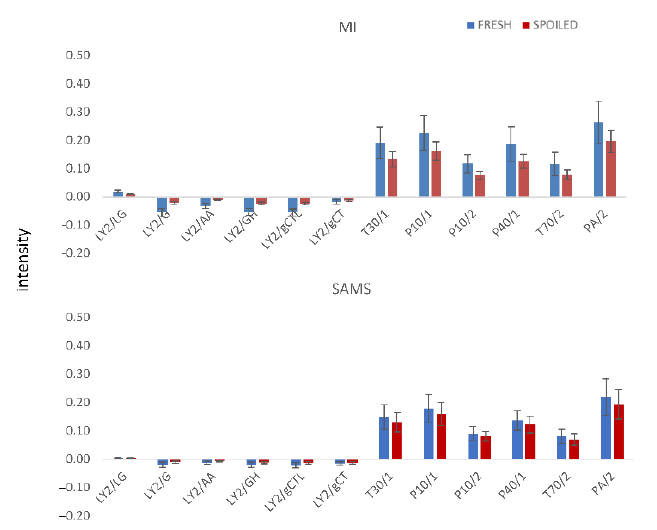
Figure 4. Maximum response values (resistance) from 12 MOS sensors of fresh and spoiled samples originating from MI and SAMS.